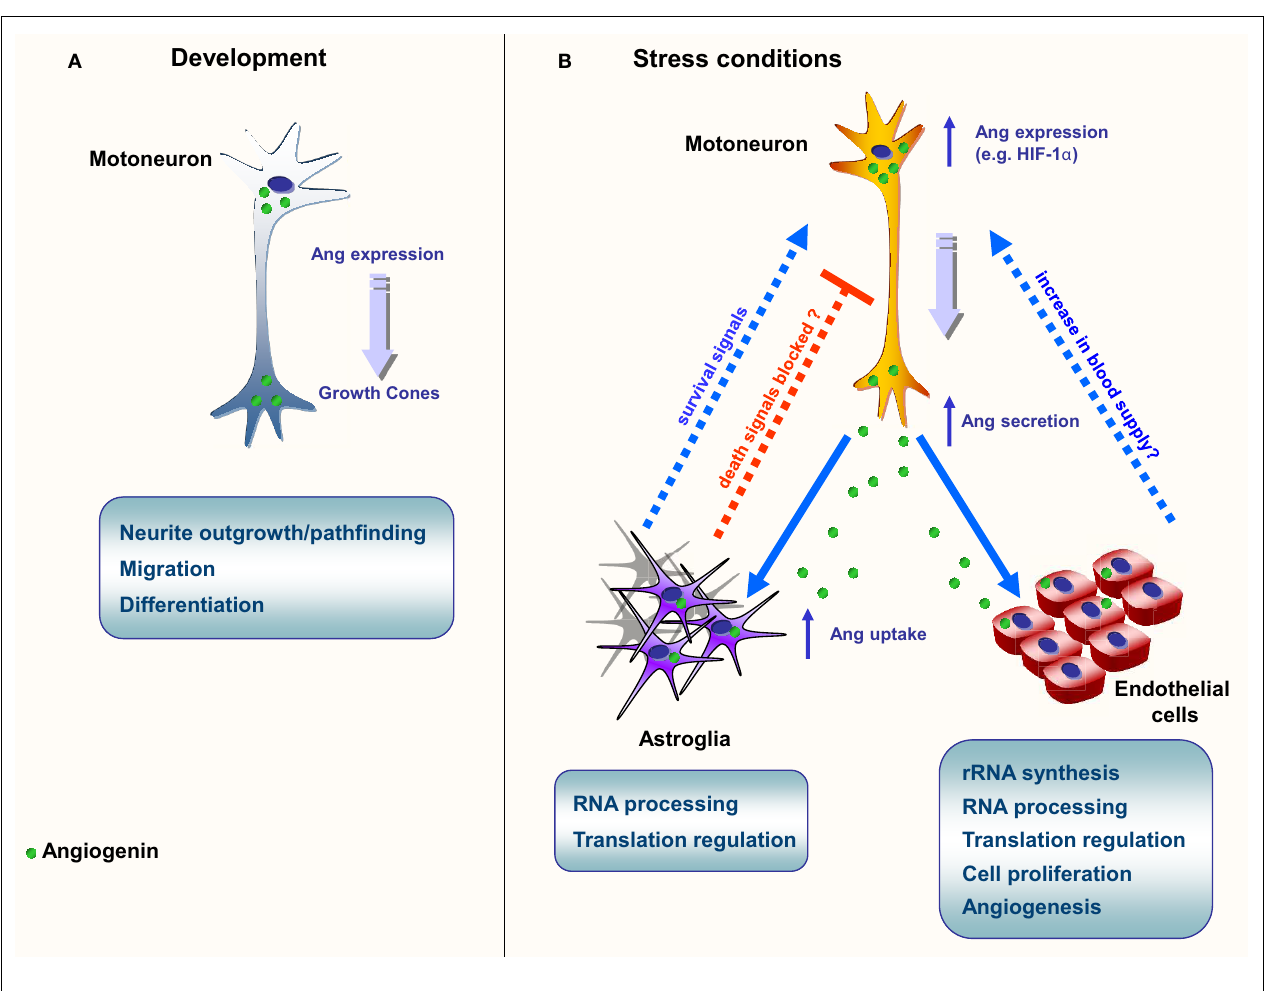
astroglia and close endothelial cells. In astroglia, angiogenin processes RNA, possibly altering the protein translation profile. A similar phenomenon is proposed to happen in endothelial cells, culminating in the production of survival signals (astroglia) and angiogenesis (endothelial cells), possibly resulting in increase of blood flow in affected